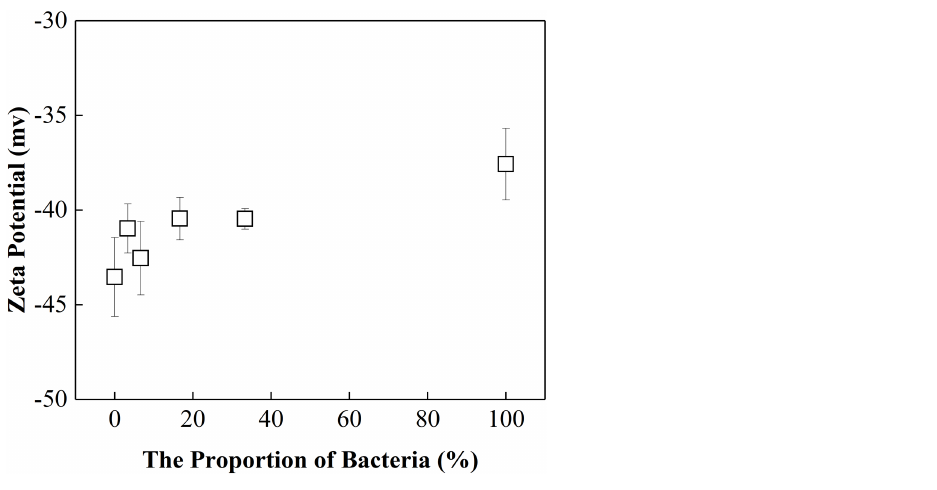
Figure 5 Zeta potential of ‘‘kaolinite- P. putida ’’ mixed particle as a function of P. putida content at pH 8.0.